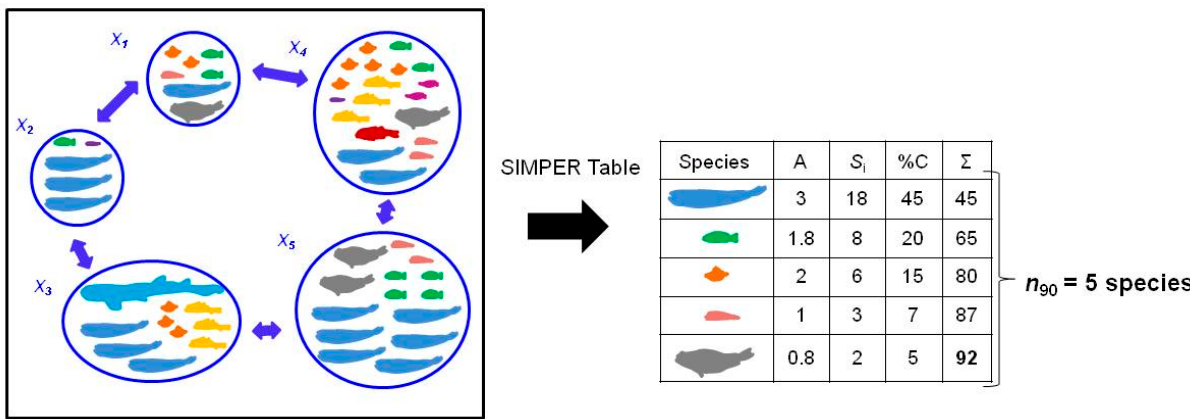
Figure 1. Calculation of number of species contributing to 90% similarity from SIMPER analysis in a group with 5 samples ( n 90 ). SIMPER table associated with n 90 is also presented, where A is the average abundance of each species in the group; S i is the contribution of each species to within-group similarity; %C is the percentage contribution of each species to within-group similarity; and Σ is the cumulative percentage contribution. Intra-group similarity for this example was Sim = 40.8.